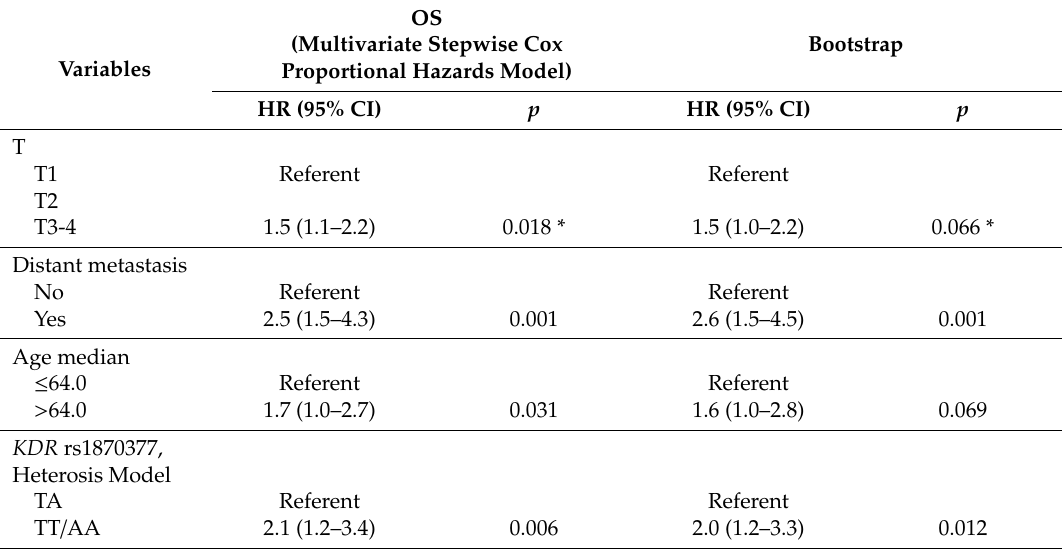
Table 3. Multivariate analysis of relevant variables for overall survival (OS) in the discovery set ( n = 167) using stepwise Cox regression, followed by Bootstrap analysis (Montecarlo simulations with 1000